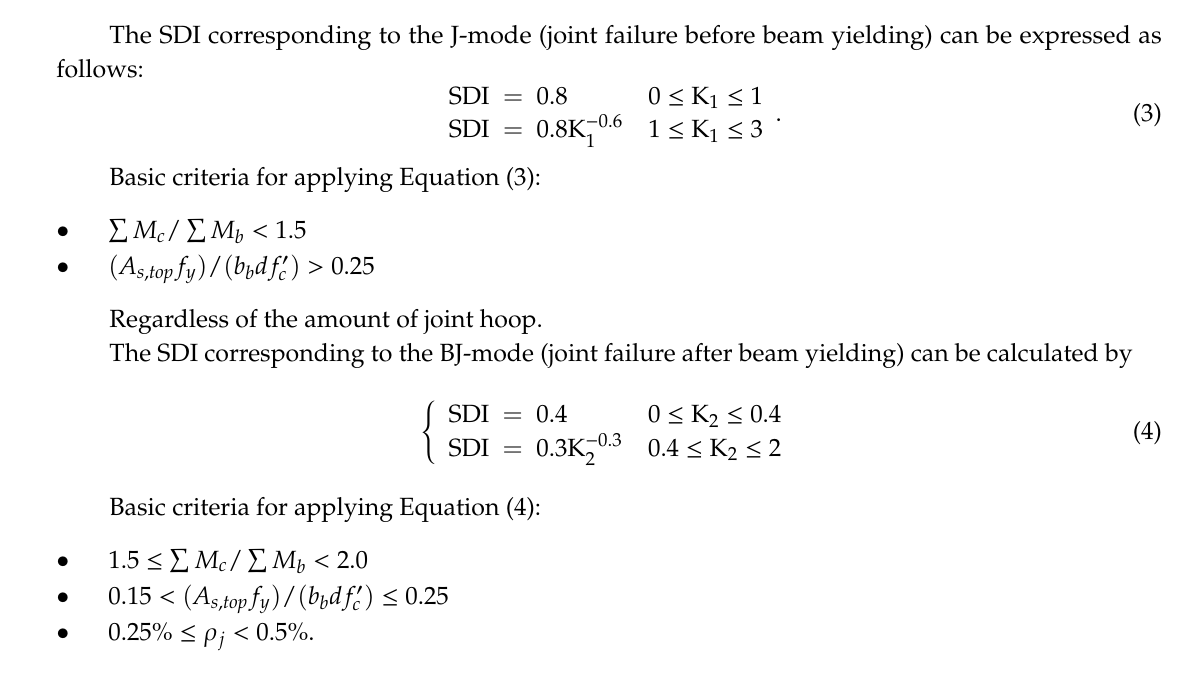
Figure 20. SD index corresponding to B-Failure